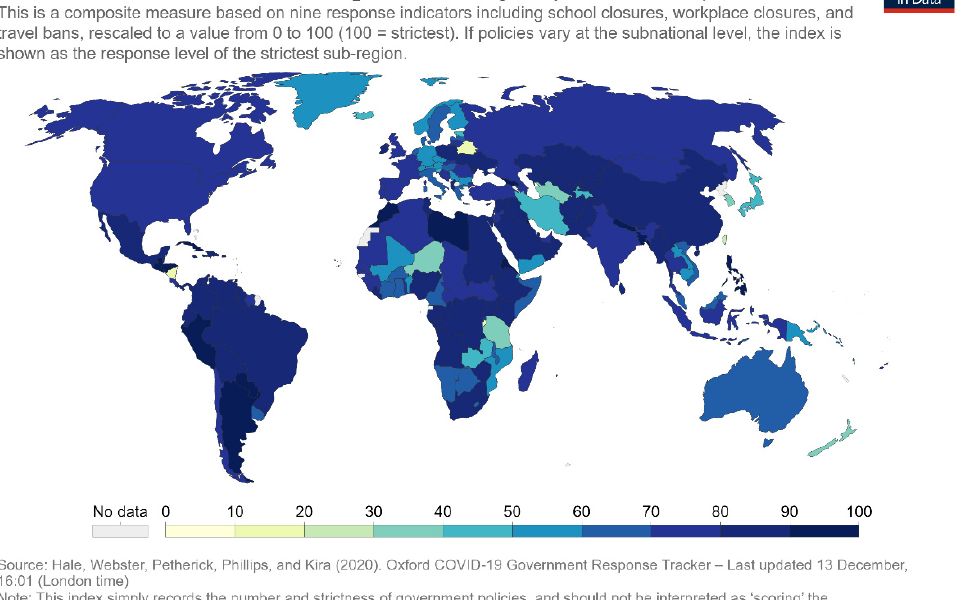
Figure 1. Government response stringency index on 21 May 2020.